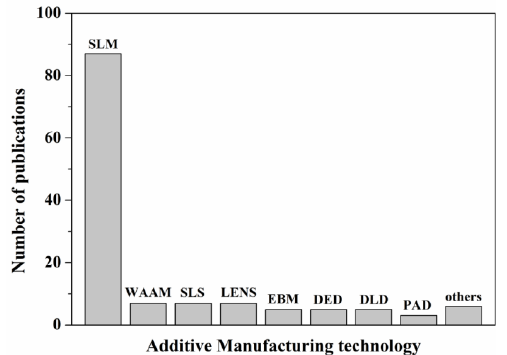
Figure 3. Number of papers published in the Web of Science database for the different AM technol-